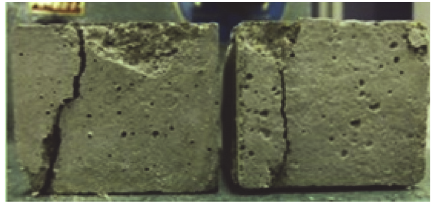
Figure 5: Reference mortar compressive failure